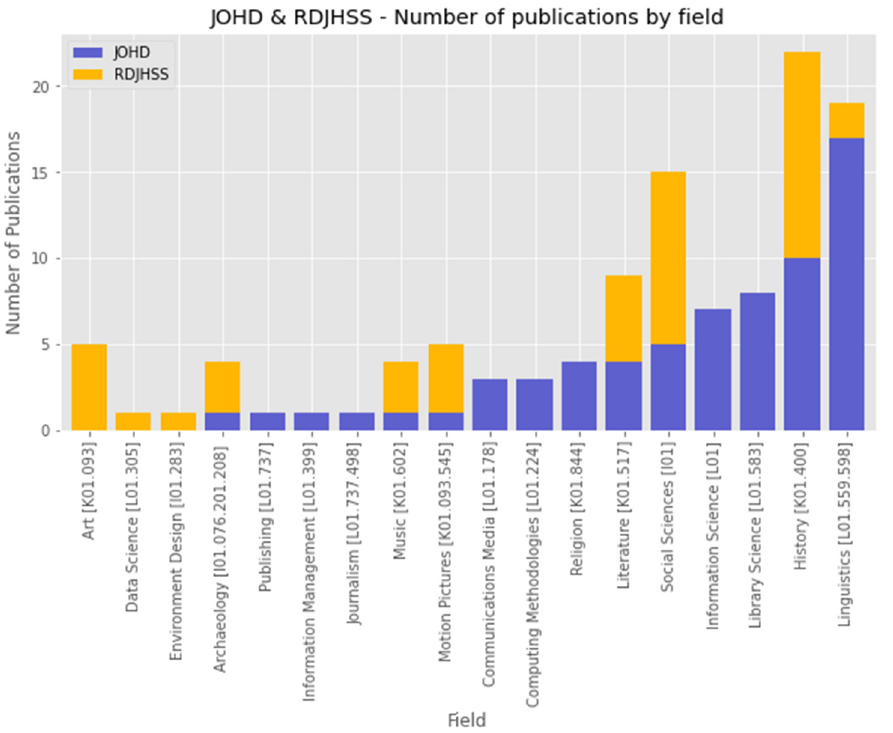
Figure 4. Distribution of the research fields represented as MeSH hierarchical labels in JOHD and RDJ papers.